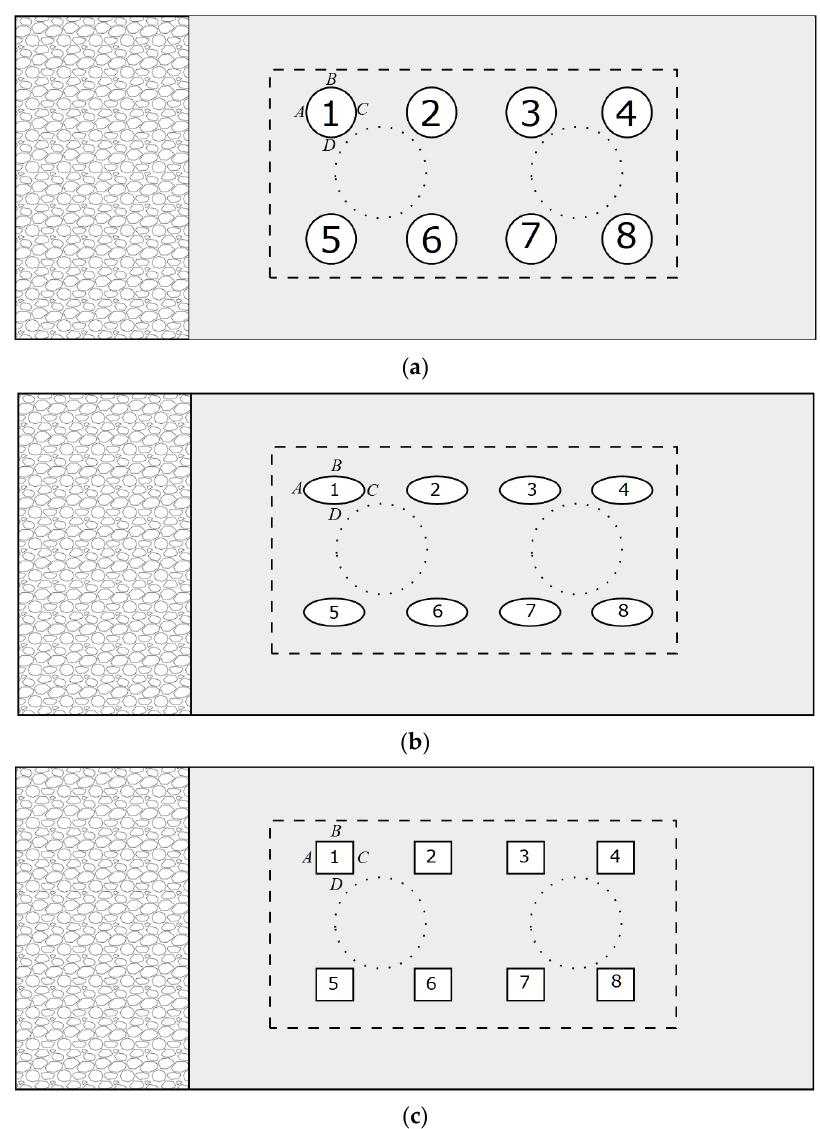
Figure 7. Point of measurement around: ( a ) circular; ( b ) lenticular; ( c ) square piles.